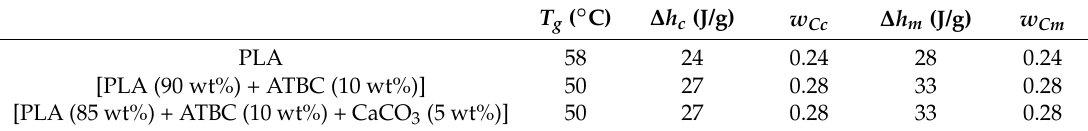
Table 2. Glass transition temperatures ( T g ), enthalpy of cold crystallization ( Δh c ), enthalpy of fusion ( Δh m ), and crystalline weight fraction growing during cold crystallization ( w Cc ) and disappearing during fusion ( w Cm ) for PLA and PLA mixed with (1) ATBC and (2) ATBC and the mineral filler CaCO 3 (estimated errors: ± 0.5 °C for T g ; ± 1 J/g for Δh c and Δh m , and ± 0.02 for w Cc and w Cm ). T g (°C)